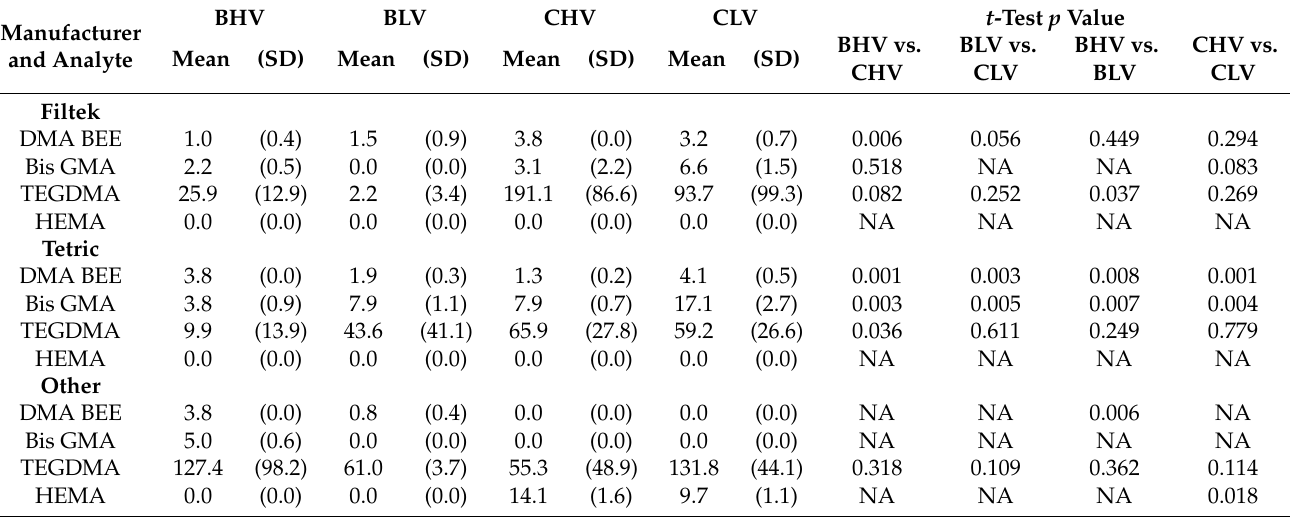
Table 3. Concentration of different compounds leached from different types of dental material preparations from the same manufacturer after 24 h.